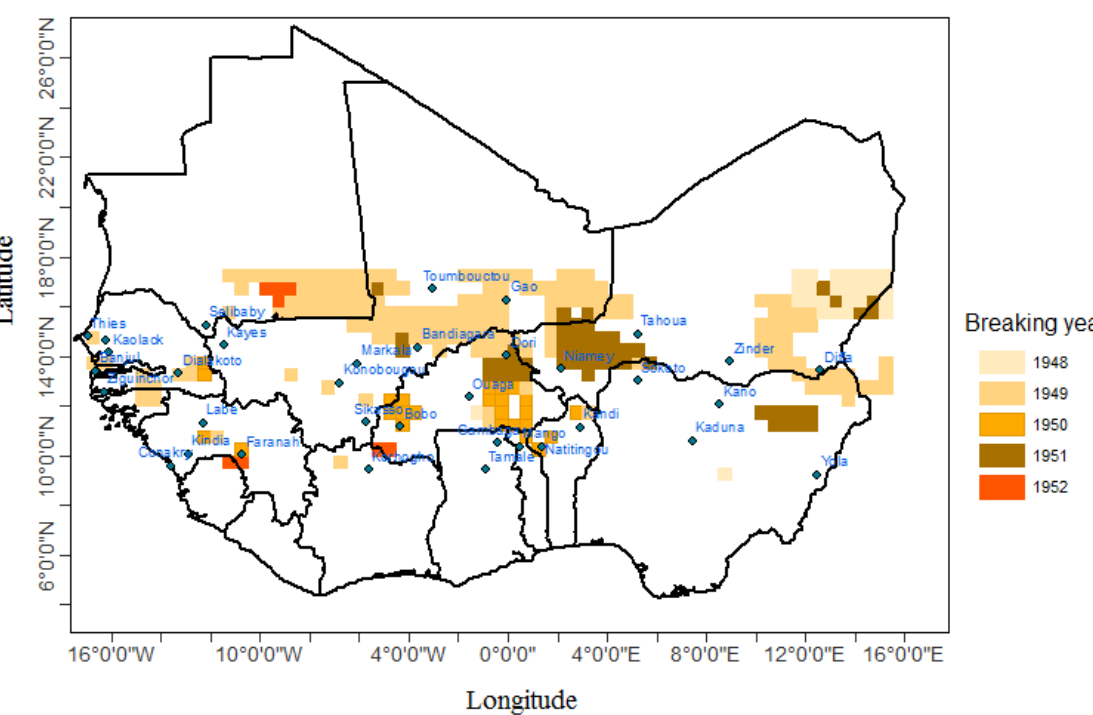
Figure 7. Geographical distribution of the breaks between the 1948–1952 period from the CRU_1995 data.